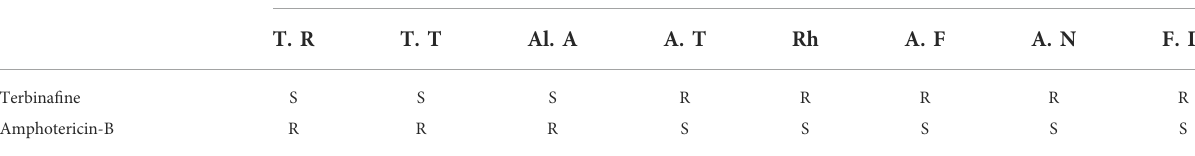
TABLE 4 Resistance pro fi ling of selected antifungals against dermatophyte and non-dermatophyte clinical isolates. Selected